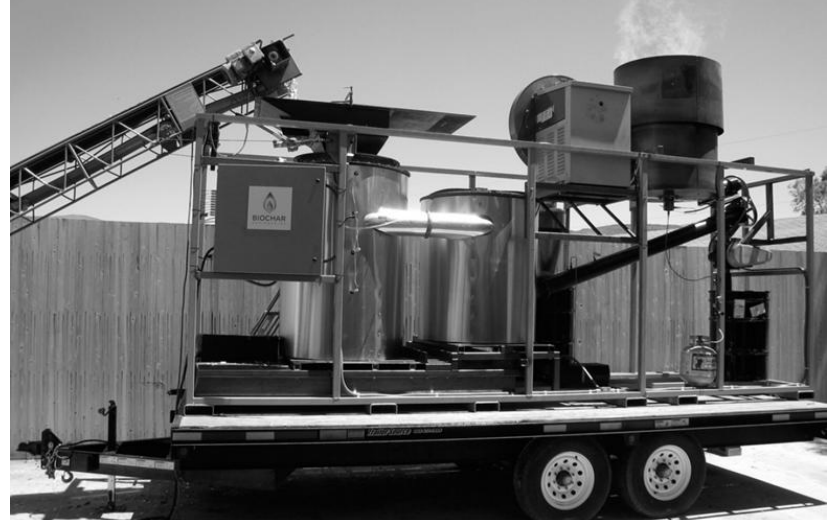
Figure 2. The Biochar Systems Incorporated (BSI), pyrolysis system Beta model used in this study. The unit used in this study was fitted with a thermal oxidizer (not shown), which replaces the open flare shown on the right. Photo: